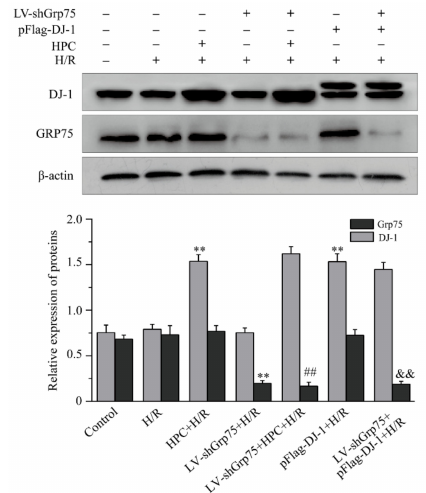
Figure 2. Western blot analysis of DJ-1 and Grp75 proteins expression in di ff erent treatment H9c2 cells. H9c2 cells were infected by lentiviral (LV) vectors LV-shGrp75 for 72 h and then subjected to hypoxic preconditioning (HPC) 24 h prior to hypoxia / reoxygenation (H / R) or transfected with pFlag-DJ-1 for 48 h followed by H / R. The expressions of DJ-1 and Grp75 proteins were determined by Western blot with the densitometric analysis normalized by β -actin. A representative blot of each experiment is shown with the densitometric analysis corresponding to the mean ± SD of three independent experiments.